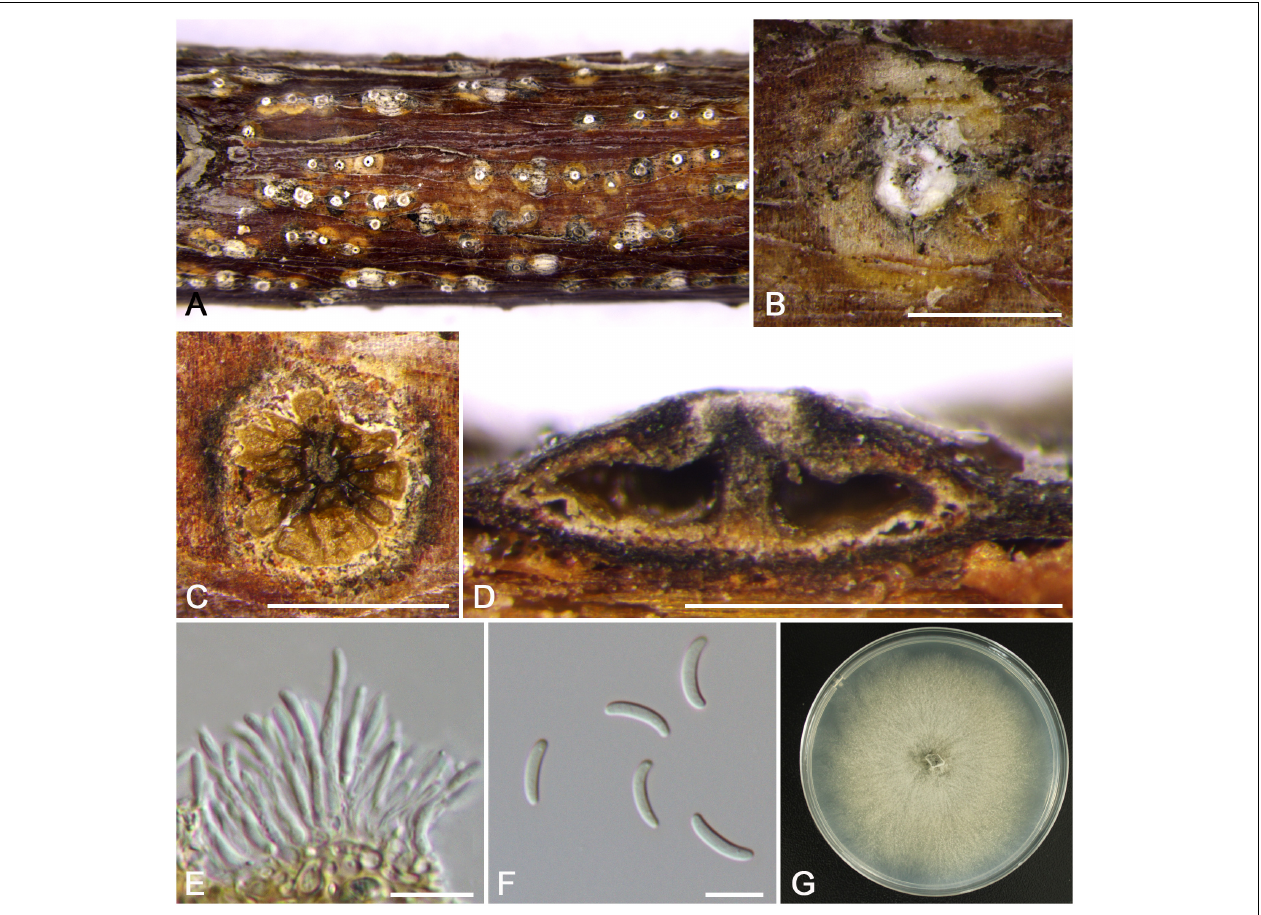
FIGURE 6 | Morphology of Cytospora mali-spectabilis from Malus spectabilis ‘Royalty’ (CF 20197665). (A,B) Habit of conidiomata on twig. (C) Transverse section of conidioma. (D) Longitudinal section through conidioma. (E) Conidiophores and conidiogenous cells. (F) Conidia. (G) Colonies on PDA for 2 weeks. Bars: (B–D) = 500 µ m; (E,F) = 10 µ